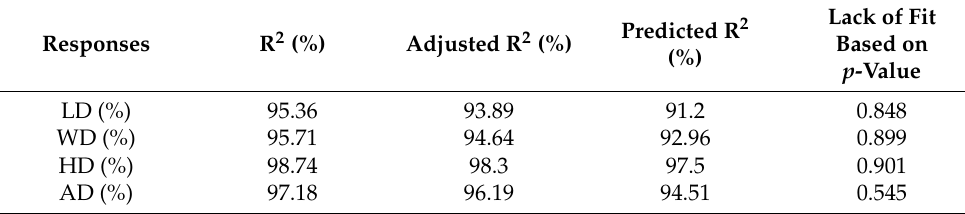
Table 3. Models summary of dimensional